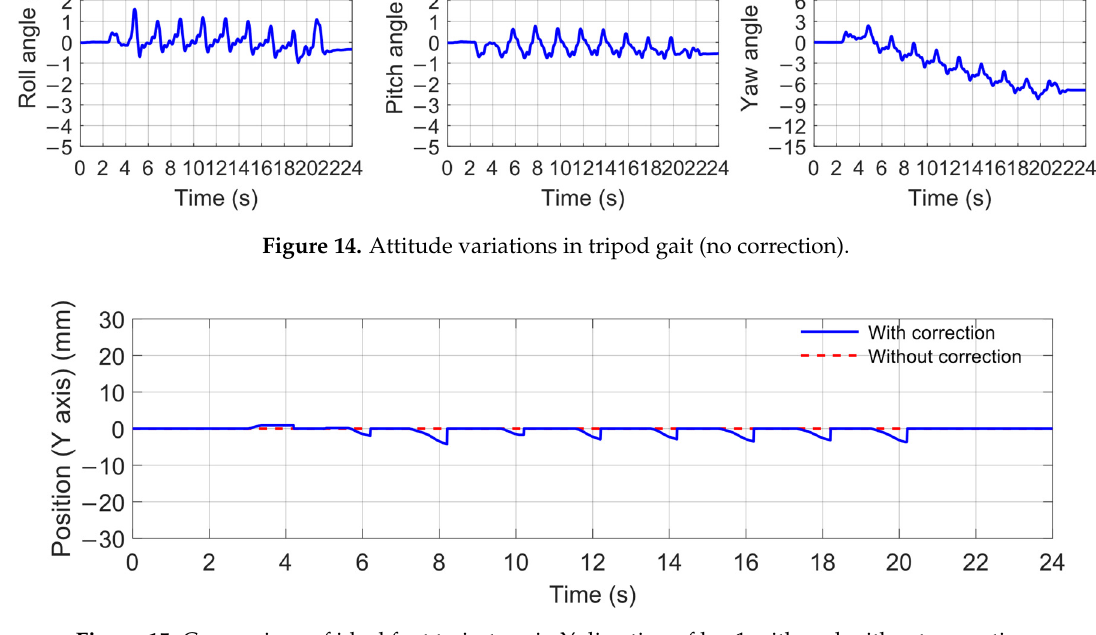
Figure 15. Comparison of ideal foot trajectory in Y direction of leg 1 with and without correction. Figure 16. Attitude variations in tripod gait (with correction). It can be seen that the yaw angle correction algorithm has played a good role. The robot can reduce the yaw angle error by adjusting the direction in time during the motion. Table 3 compares the mean, standard deviation (SD) and root mean square error (RMSE) relative to the ideal value (0°) of the yaw angle data in two experiments. In the subsequent experiments, the yaw angle correction strategy is adopted by default.